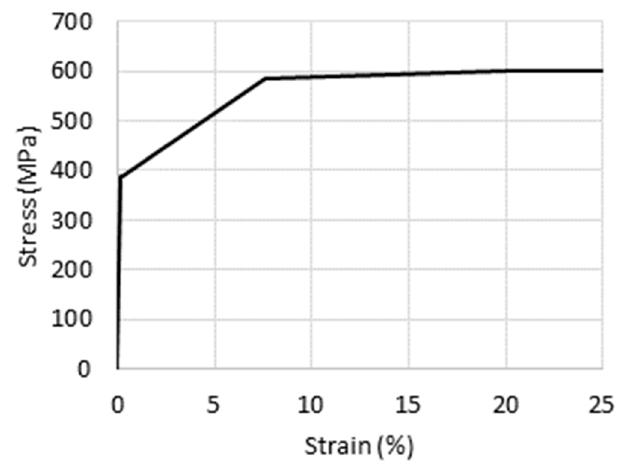
Figure 6. Stress–strain curve of the applied material model.